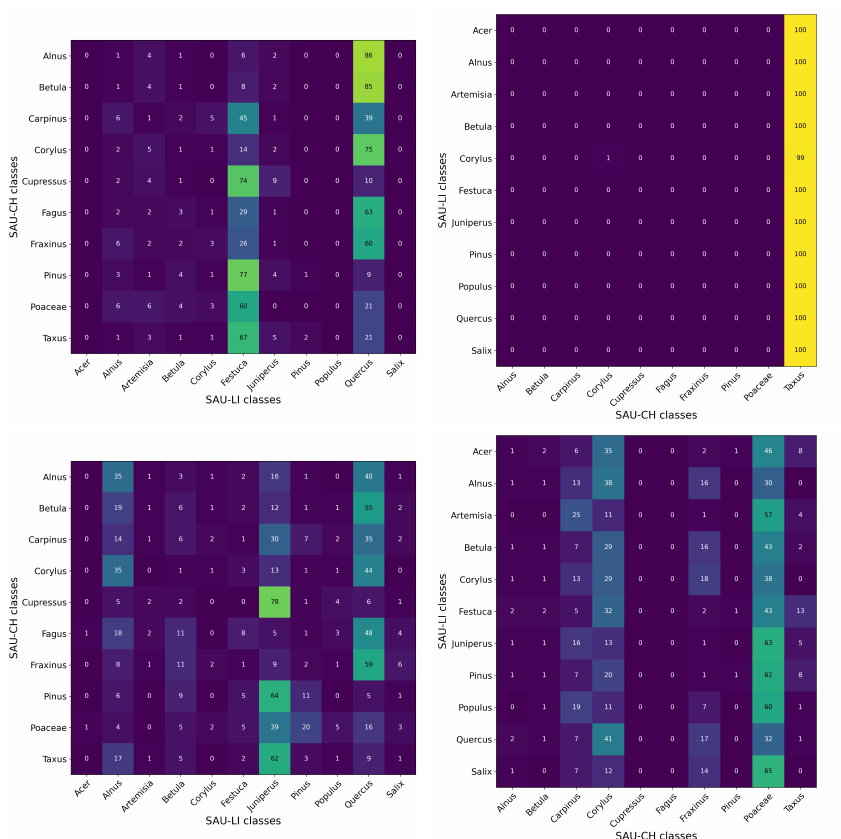
Figure 11. Left: Confusion matrix created on the test set from the SAU-CH dataset with feature extractor models trained on the training set from SAU-LI. From top to bottom: scattering FE, spectrum FE, lifetime FE. Right: Confusion matrix created on the test set from the SAU-LI dataset with feature extractor models trained on the training set from SAU-CH. From top to bottom: scattering FE, spectrum FE, lifetime FE. Values are